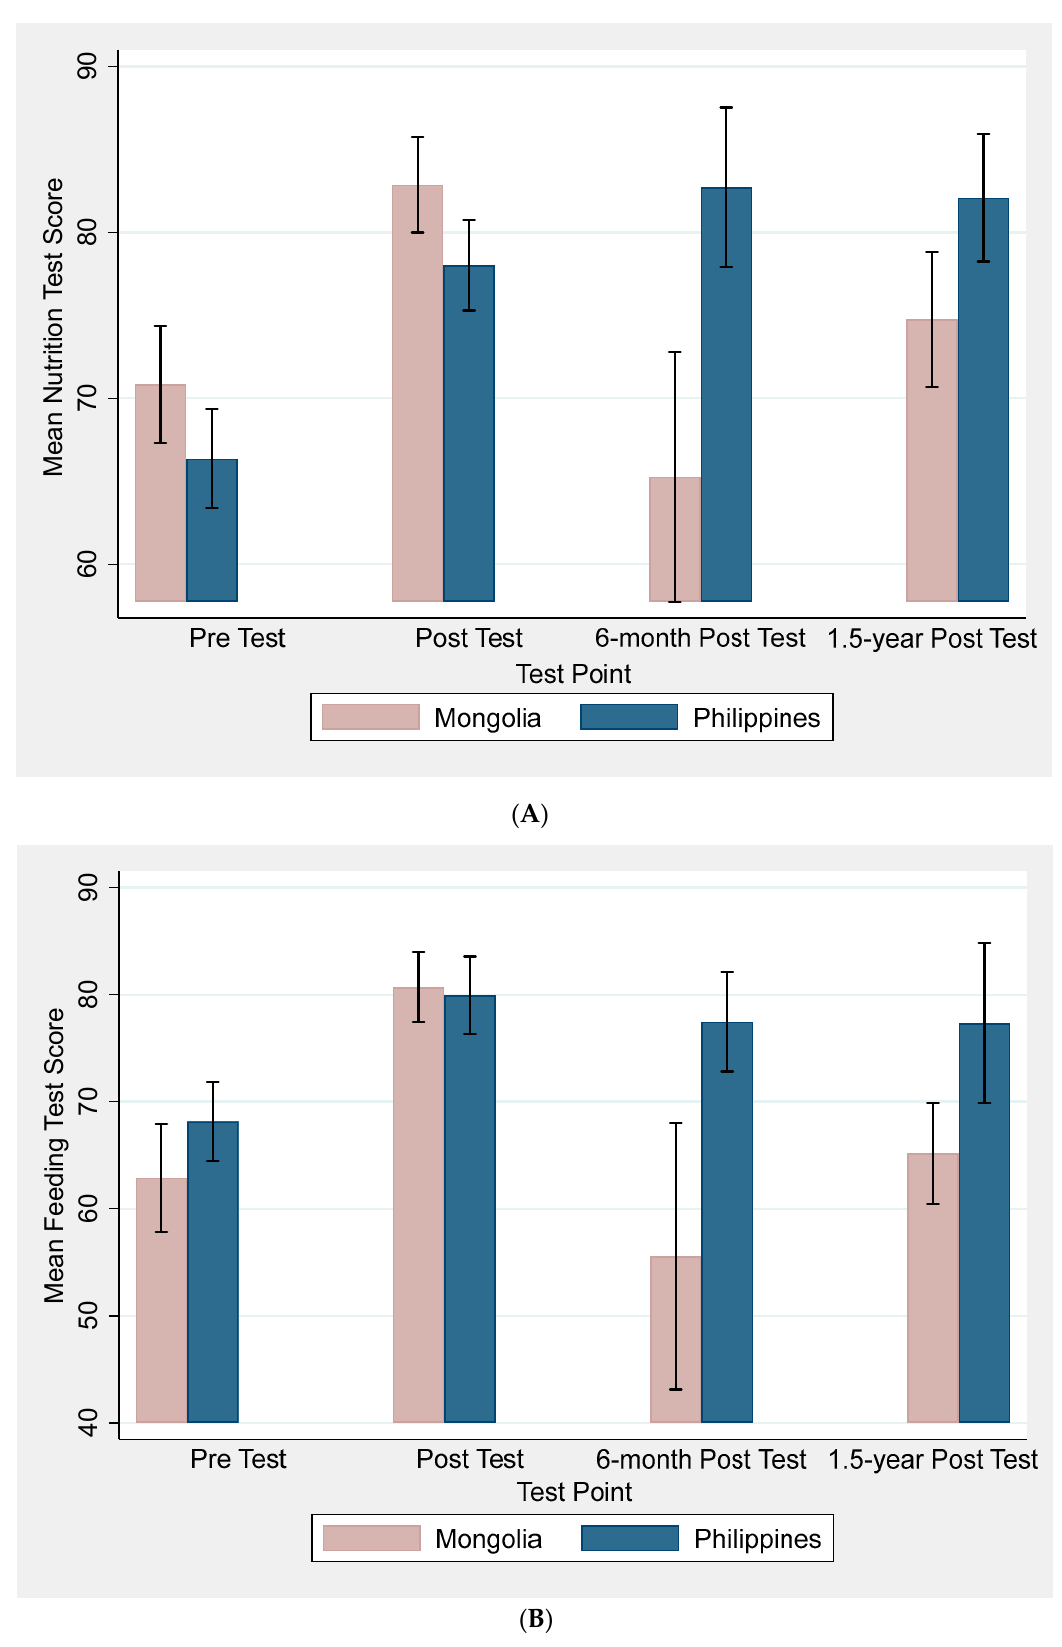
Figure A1. Mean Nutrition ( A ) and Feeding ( B ) Test Scores at Pre-training, Post-training, 6-month Post-training and 1.5-year Post-training. Error bars show 95% confidence intervals.